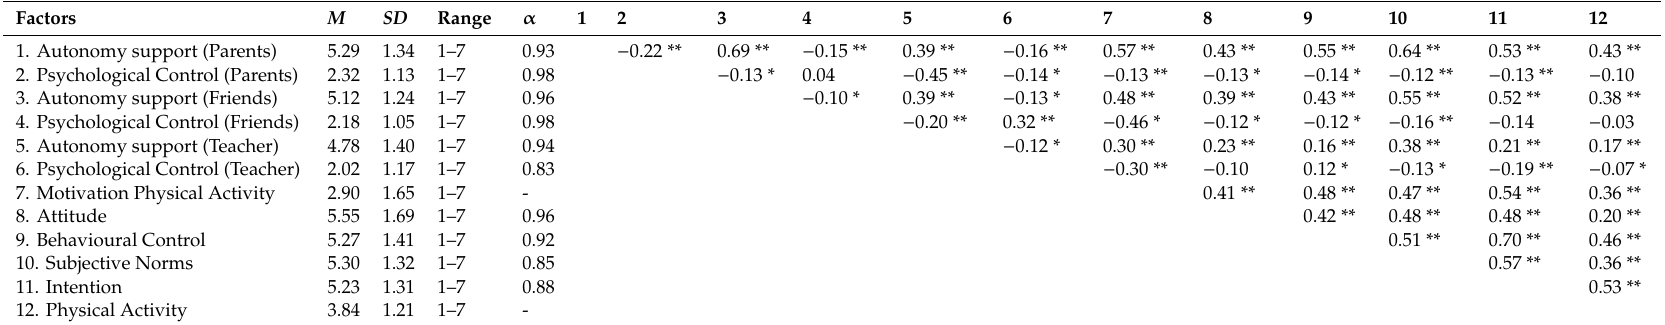
Table 4. Descriptive statistics, internal consistency analysis and bivariate